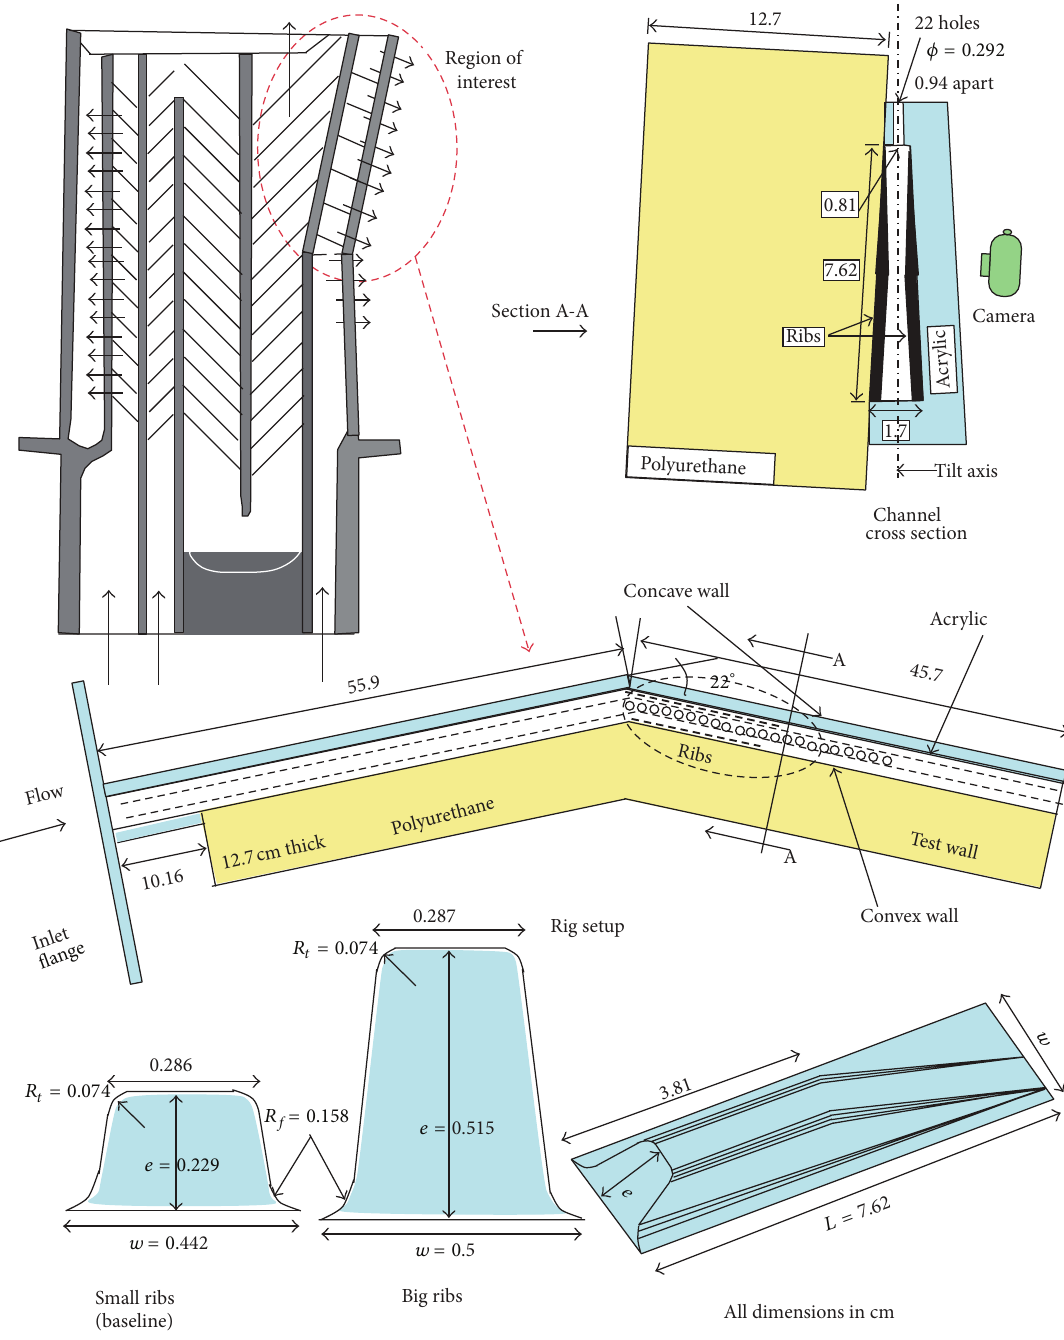
Figure 1: Schematics of the rig and the